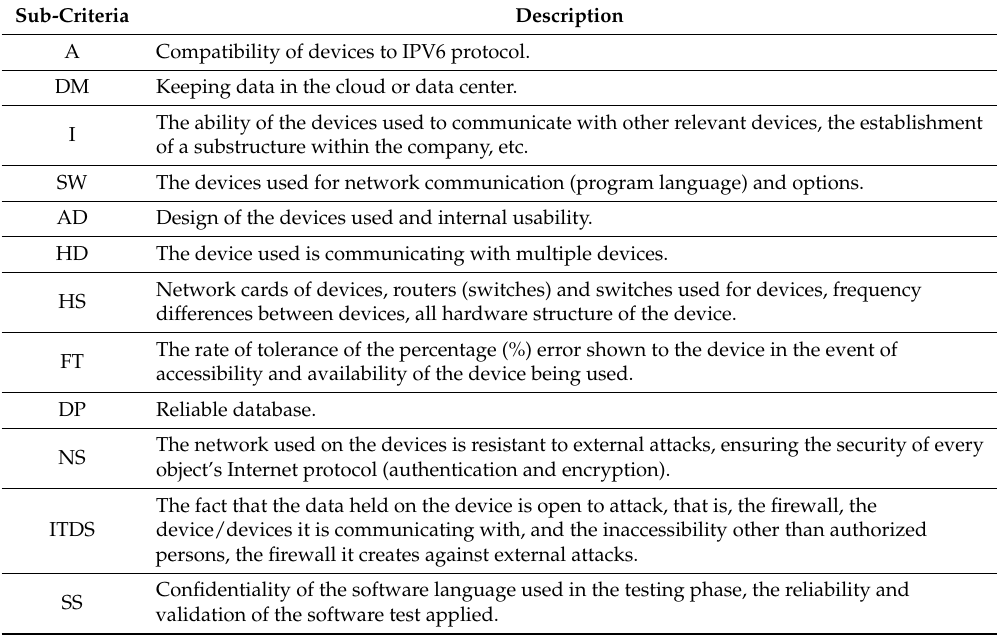
Table 2. Sub-criteria